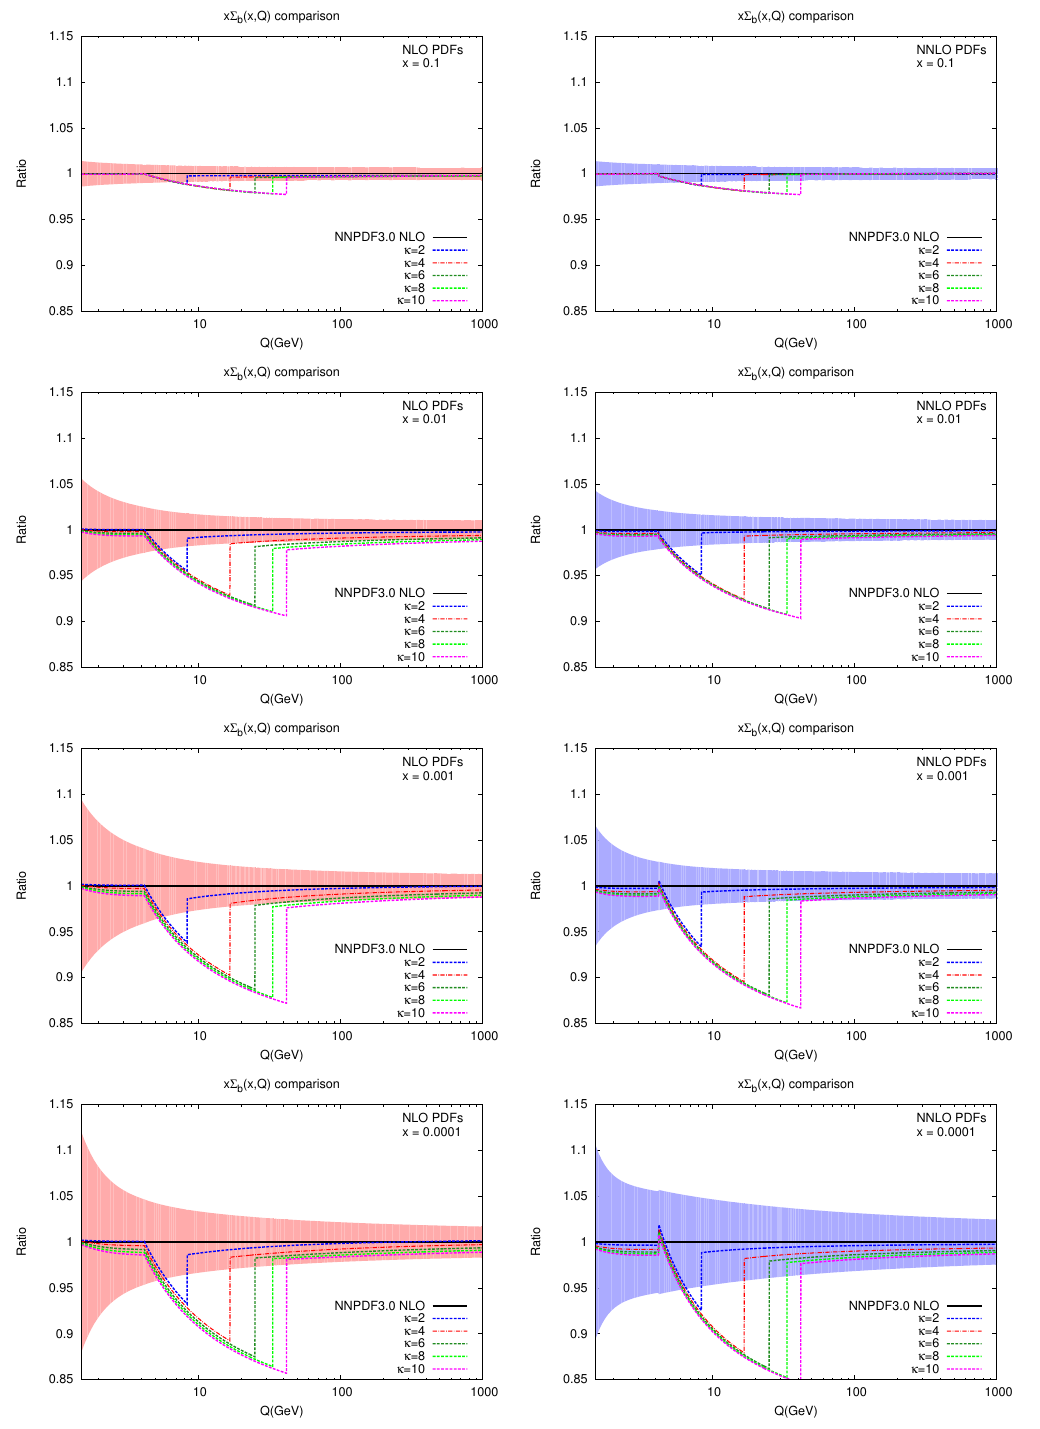
Figure 15 . As in (cid:12)gure 13 but for (cid:6) = u + (cid:22) u + d + (cid:22) d + s + (cid:22) s + c + (cid:22) c + b + (cid:22) b